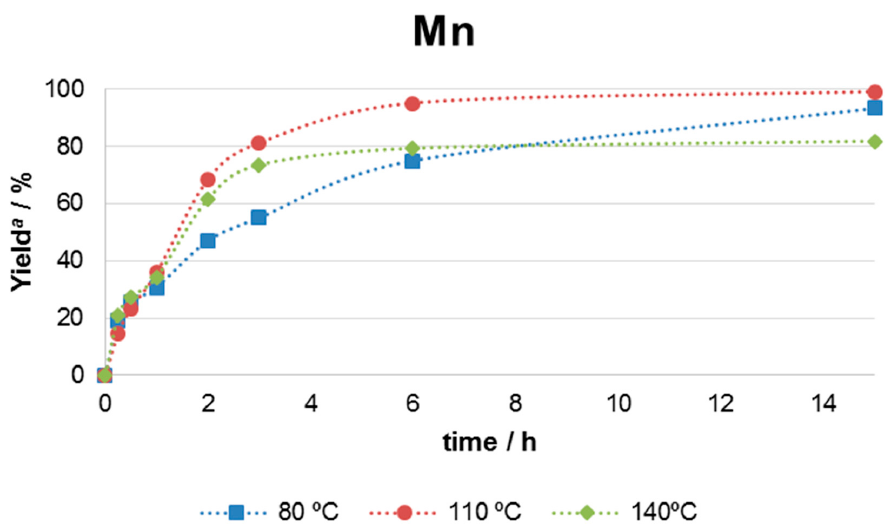
Figure 8. Acetophenone yields vs . reaction time in the solvent ‐ free traditional heated oxidation of 1 ‐ phenylethanol using Fe 3 O 4 @EDTA ‐ Mn 2+ ( 1 ) as catalyst. Reaction conditions: catalyst (30 mg), 1 ‐ of 1-phenylethanol using Fe 3 O 4 @EDTA-Mn 2+ ( 1 ) as catalyst. Reaction conditions: catalyst (30 mg), phenylethanol (2.5 mmol), t ‐ BuOOH aq. 70% (5.0 mmol). a Moles of acetophenone per 100 mol of 1 ‐ 1-phenylethanol (2.5 mmol), t -BuOOH aq. 70% (5.0 mmol). a Moles of acetophenone per 100 mol of 1-phenylethanol (GC yield), >99% selectivity. Catalysts 2017 , 7 , 335 12 of 19